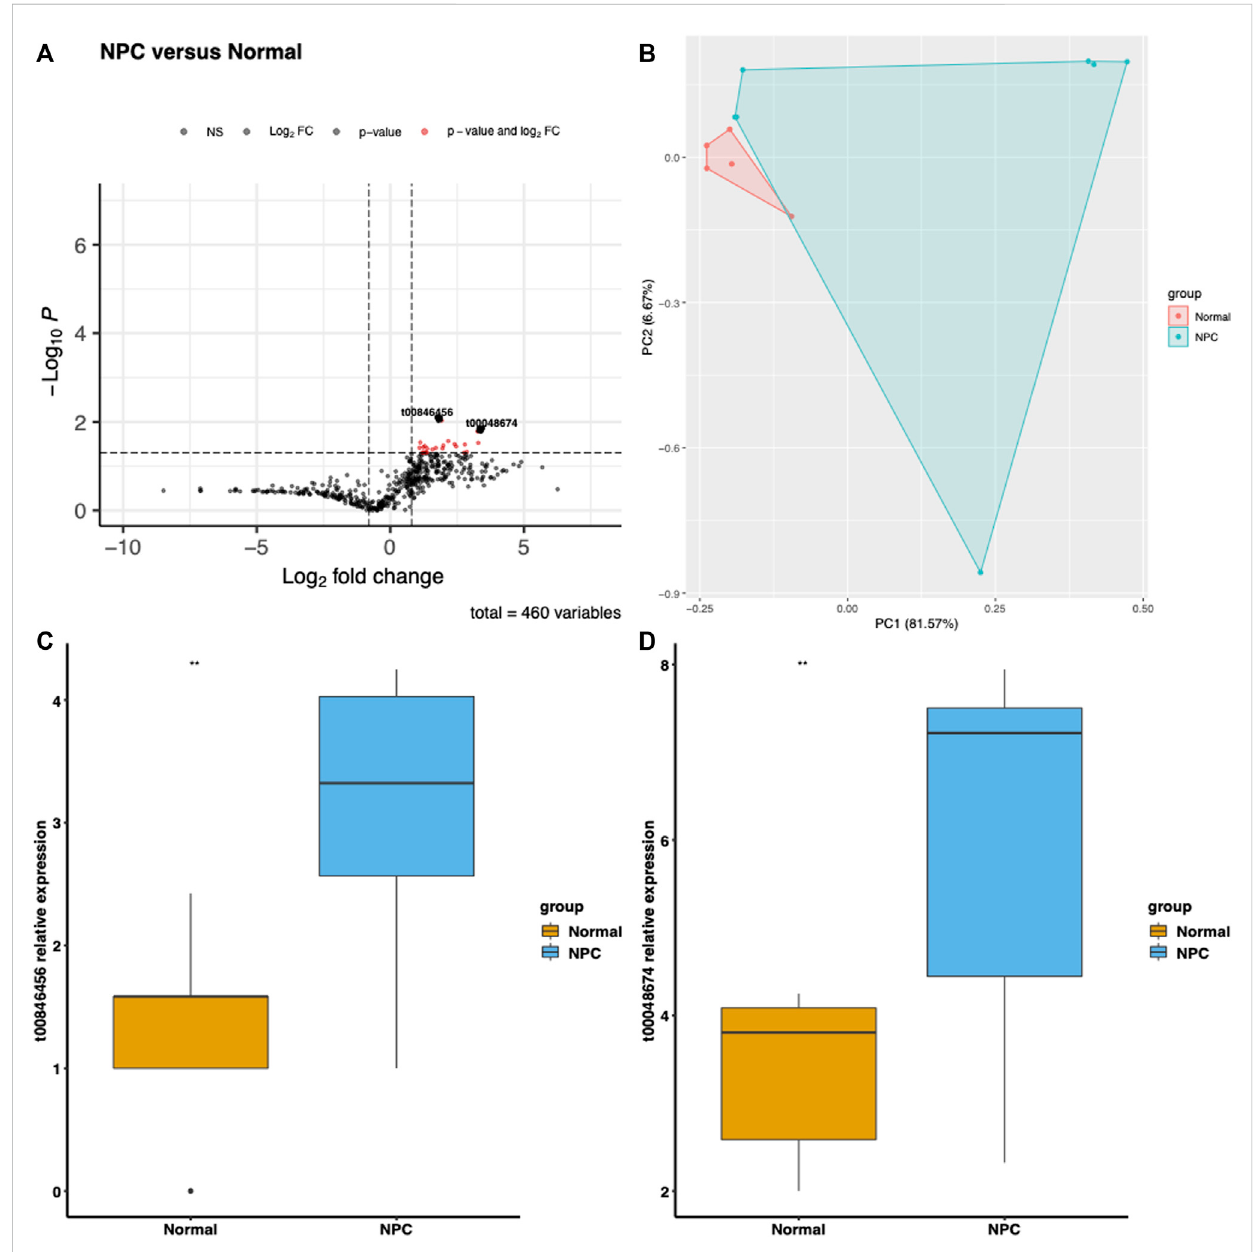
FIGURE 1 DifferentialgeneexpressioninNasalPharyngealCancerandNormalgroups. (A) Volcanoplotdisplayingthelog2foldchangeand-log10 p -valuefor each gene in the dataset. Comparing the expression levels of nasal pharyngeal cancer and normal groups for two signi fi cantly expressed mitochondrial- derived small RNAs, t00048674 and t00846456, which were selected based on a Log2FoldChange > 1 and p -value < 0.05 criterion. (B) Principal component analysis (PCA) plot illustrating the differentiation between Nasal Pharyngeal Cancer and Normal samples based on gene expression levels. Each point represents a sample, with Nasal Pharyngeal Cancer samples indicated in red and Normal samples in blue. The plot shows the fi rst two principal components (PC1 and PC2), which account for the majority of the variation in the data. (C) Boxplot of t00846456 showing the distribution of expression levels in Nasal Pharyngeal Cancer and Normal groups. The expression level of t00846456 is signi fi cantly upregulated in the Nasal Pharyngeal Cancer group. (D) Boxplot of t00048674 displaying the distribution of expression levels in Nasal Pharyngeal Cancer and Normal groups. The expression level of t00048674 is also signi fi cantly upregulated in the Nasal Pharyngeal Cancer